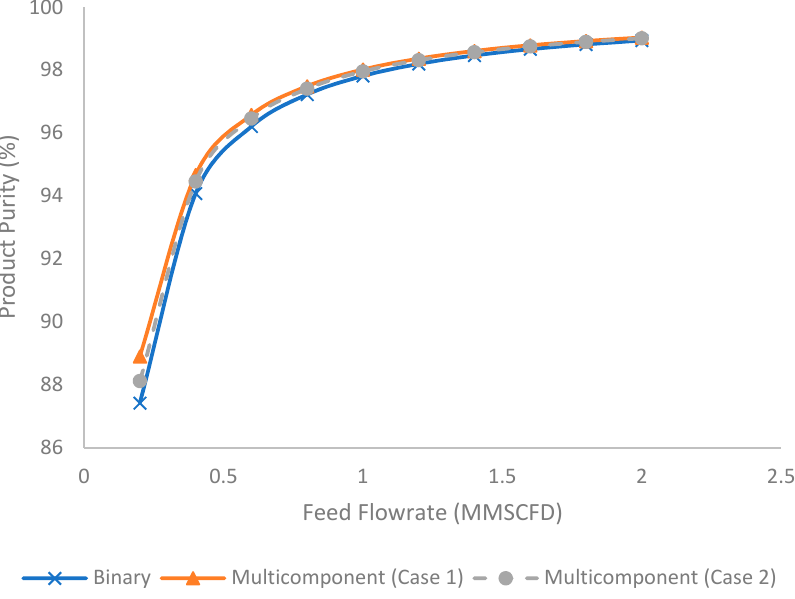
Figure 11. Evolution of product purity (%) under different feed flow rates for binary and multicom- ponent systems.